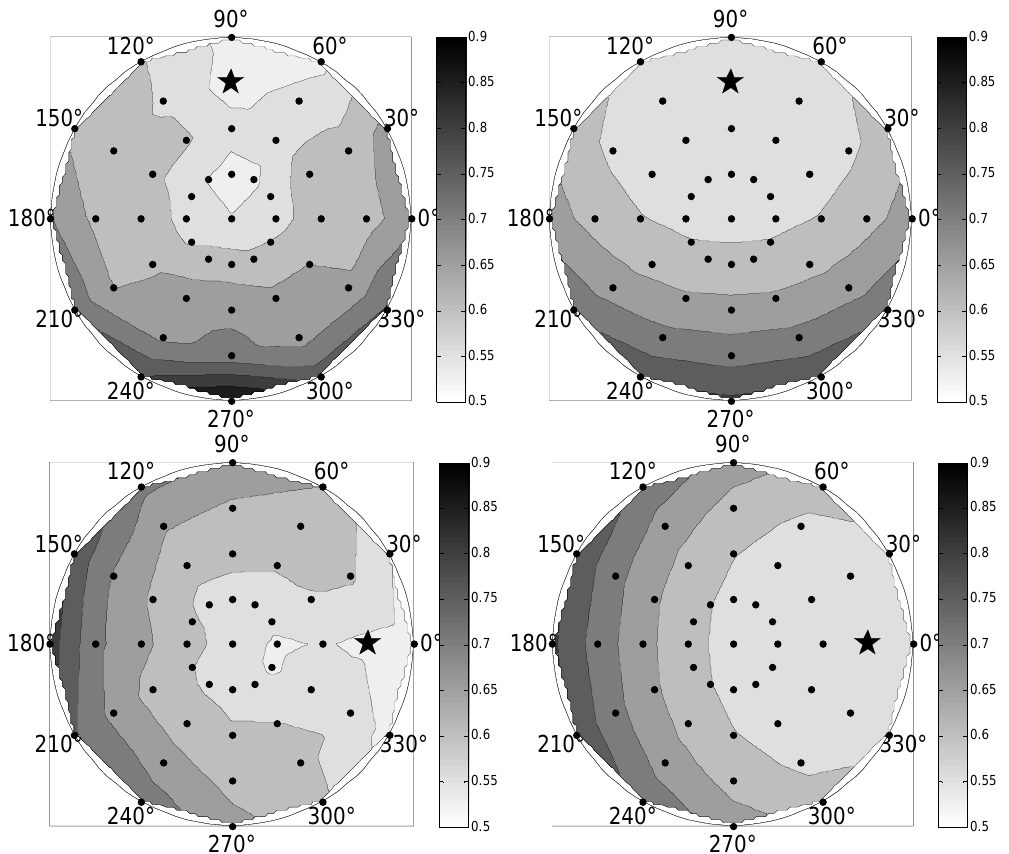
Figure 4. Bidirectional Reflectance Factors of a Fagus sylvatica L. leaf at 850 nm, for light source position set at 45° zenith and 90° azimuth (top panel) and 45° zenith and 0°azimuth (bottom panel). On the right side of the Figure the simulated RPV Bidirectional Reflectance Factors are presented for the same angular and wavelength configurations. The sensor is azimuthally positioned all over the hemisphere and ranges in zenith between 0°and 60°, with 15° increments. Sensors positions are marked by dots, while incident direction is presented by a star. The bar scale indicate reflectance